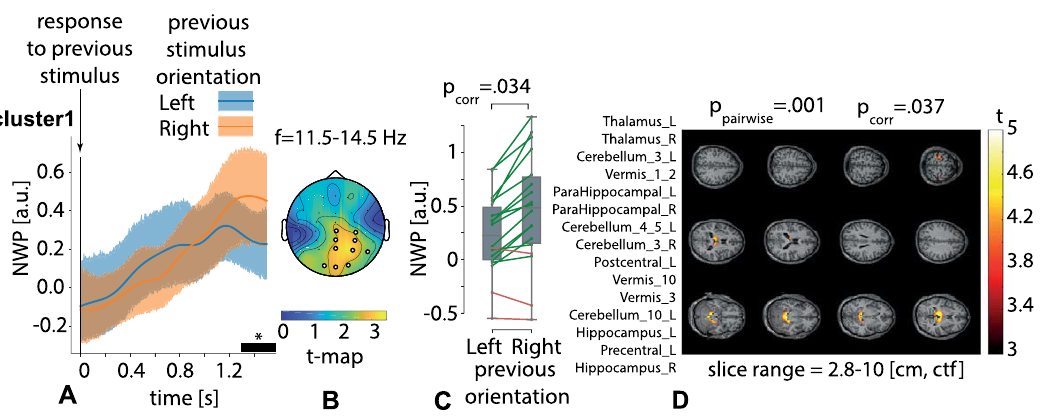
Figure 8. Significant cluster as the result of NWP comparison after responding to the right- and left-oriented stimuli on the 1.5-s interval time-locked to the behavioral response (vertical solid line). The orange and blue curves ( A ) show the NWP evolution (group means and 95% CI) in these clusters after responding to the left- and right-oriented stimuli. The topogram ( B ) reflects the t -value and the channels demonstrating a significant change of NWP between analyzed conditions on the EEG sensor level. The box-plot ( C ) illustrates NWP in this cluster averaged over the time interval, frequency band, and channels. The slice-plot ( D ) reflects the t -value for the voxels included in the source-level cluster. p corr is corrected for multiple comparisons via the cluster-based test with the Monte-Carlo randomization